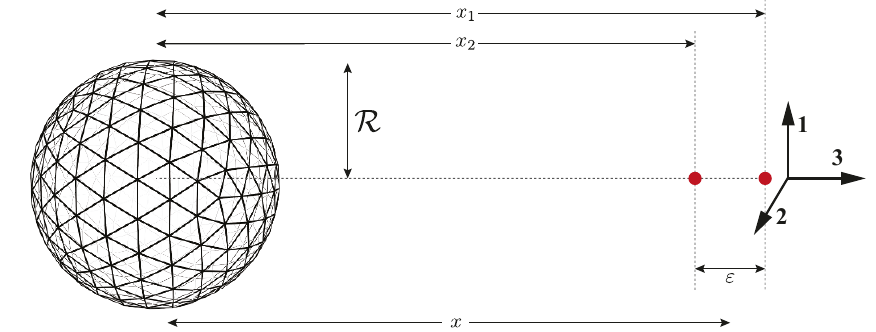
Figure 1 . A spherical membrane of (cid:12)xed radius R and N units of light-cone momentum, and two probes far away and colinear with it. x k = r k =l P with k = 1 ; 2 are the locations of the probes in eleven dimensional Planck units, and we de(cid:12)ne " = x 1 (cid:0) x 2 while x = ( x 1 + x 2 ) =